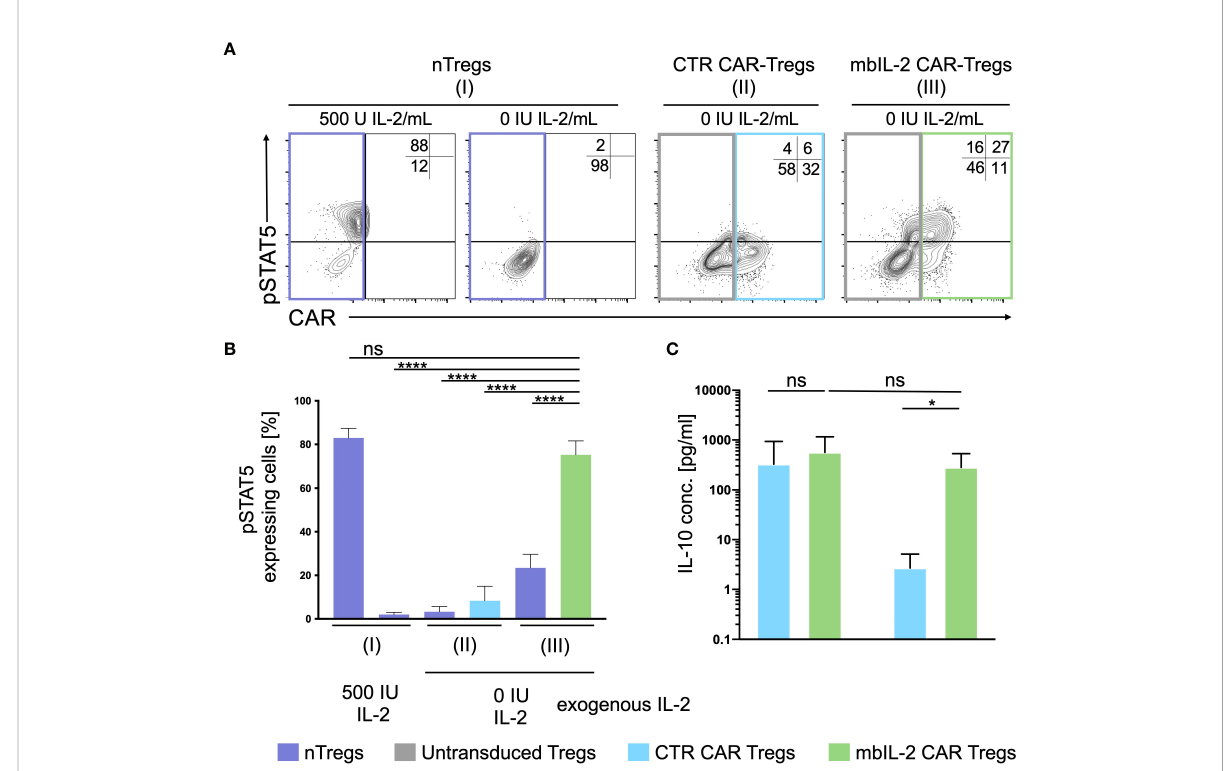
FIGURE 4 Expression of membrane-associated IL-2 led to STAT5 activation and enhanced IL-10 production in the absence of exogenous IL-2. (A) Representative dot plots of intracellular pSTAT5 staining in nTregs, CTR CAR-Tregs and mbIL-2 CAR-Tregs cultured under IL-2-free conditions. (B) Bar graph summarizes STAT5 activation correlated with IL-2-initiated signalling, which could be seen under IL-2-free conditions only in mbIL-2 CAR-Tregs (75,2 ± 2,8) and was comparable to that in nTregs cultured with 500 U IL-2 (83 ± 2,5). The absence of IL-2 signalling did not cause STAT5 activation, as seen in nTregs with 0 U IL-2 (2 ± 0,6) and CTR CAR-Tregs (8,3 ± 3,8). The percentage of pSTAT5 was calculated for either untransduced or transduced cells as indicated by the highlighted rectangles (n=3, 3 different individuals). Error bars show the mean ± SEM. Signi fi cance was analysed by ordinary one-way ANOVA with Dunnett ’ s multiple comparisons test. ****P ⪬ 0.0001, ns= not signi fi cant; each analysis was compared to pSTAT5 expression in mbIL-2 CAR Tregs. (C) Bar graph summarizes IL-10 measured concentrations in the supernatant of CTR CAR-Tregs and mbIL-2 CAR-Tregs cultivated under 500 U or 0 U exogenous IL-2. The absence of exogenously supplied IL-2 resulted in a decrease in IL-10 concentration. The presence of membrane-bound IL-2 in mbIL-2 CAR-Tregs stabilizes the IL-10 concentration even in the absence of IL-2 in the supernatant and is not signi fi cantly different from IL-10 concentrations measured in mbIL-2 CAR-Treg supernatant after culture with 500 U IL-2. The IL-10 concentration was measured using the BioPlex Cytokine 27-plex Assay system (Bio-Rad). n=3, 3 different individuals; signi fi cance was evaluated using an unpaired t test. Error bars show the mean ± SD. **P ⪬ 0.01, ns= not signi fi